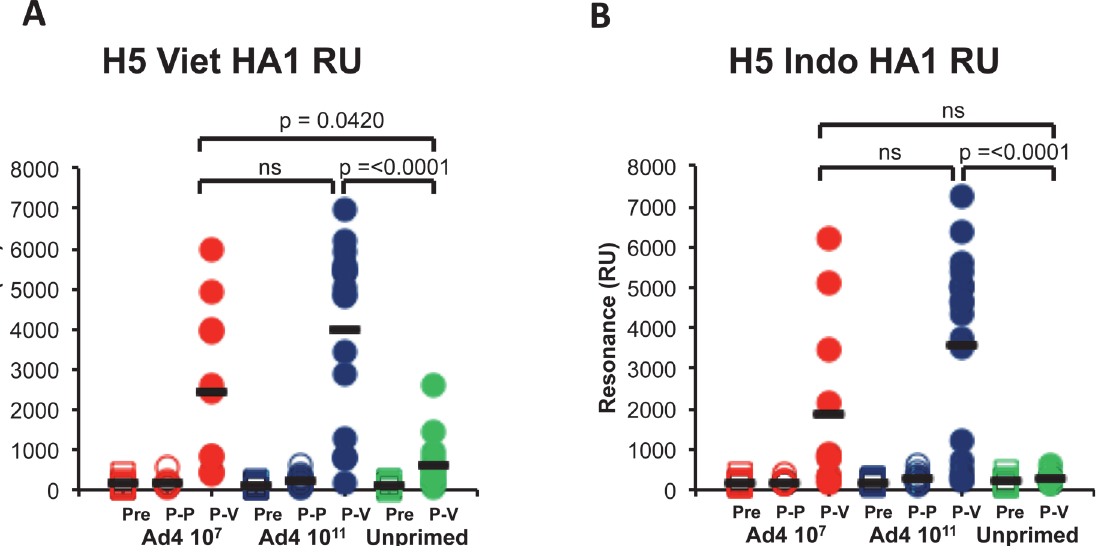
Fig 2. Binding of post-H5N1 vaccination polyclonal human serum to properly folded HA1 proteins from A/Vietnam/1203/2004 and A/Indonesia/05/ 2005. Steady-state equilibrium analysis of the total binding antibodies in the polyclonal human vaccine sera to properly folded functional H5N1-A/Vietnam/ 1203/2004 HA1-His 6 (panel A) or H5N1-A/Indonesia/05/2005-His 6 (Panel B) was measured by SPR. Each individual post-boost H5N1 serum sample, diluted ten-fold, was injected simultaneously onto HA1 immobilized on a sensor chip through the free amine group and onto a blank flow cell, free of peptide. Maximum resonance unit (Max RU) values for HA1 binding by serum antibodies obtained from multiple individuals from either low dose (10 7 VP) Ad4-H5-Vtn primed (red circles), high dose Ad4-H5-Vtn (10 11 VP) (blue circle), or unprimed (green circles) on day 0 (Pre), 28 days after the third prime (P-P), and 28 days post boost with 90 μ g HA/dose of the Sanofi Pasteur (P-V). Differences between groups (p-values) were examined for statistical significance by the multiple comparison adjustment using Bonferroni method. A p-value less than 0.05 was considered to be significant. ‘ ns ’ represents non-significant ( p = > 0.05